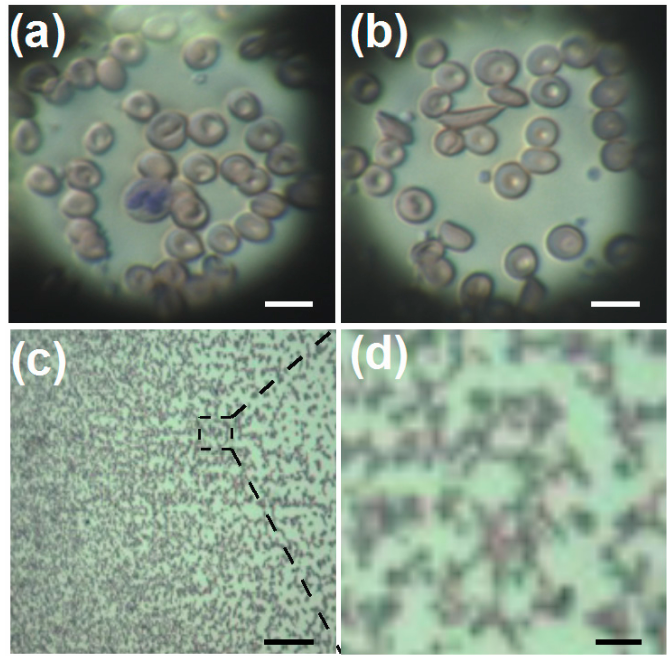
Figure 9. Wright and Giemsa stained blood smear from a patient with sickle-cell disease: neutrophils ( a ) and sickle cells ( b ) are clearly visible. In ( c , d ), the same blood smear sample as imaged from the stereo microscope alone. Scale bars: 10 µ m in (a) , (b) , (d) ; 50 µ m in (c)